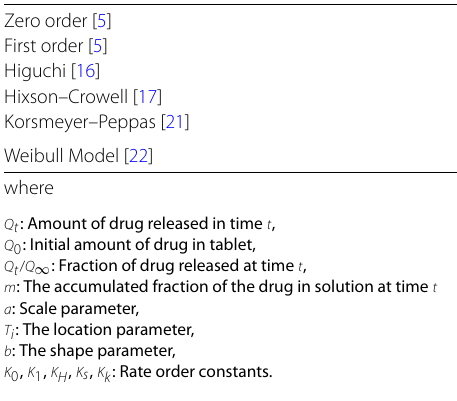
Table 1 Mathematical models for comparison of dissolution profiles